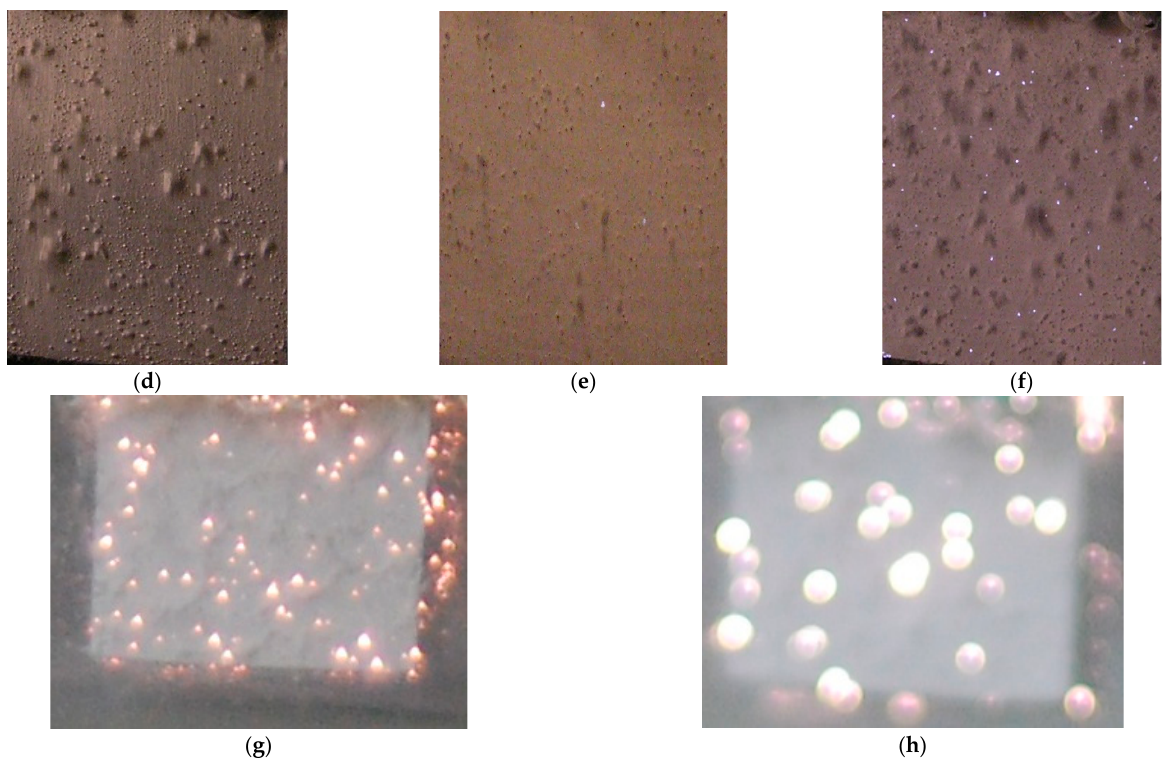
Figure 2. The bubbles and discharge sparks’ evolution on the surface of the working electrode during the different PEO processes at different voltage and time ( a ) 400 V-30 s; ( b ) 100 V-30 s; ( c ) 400 V-10 s; ( d ) 400 V-30 s; ( e ) 420 V-30 s; ( f ) 466 V-1 min; ( g ) 466 V-5 min; ( h ) 466 V-10 min.